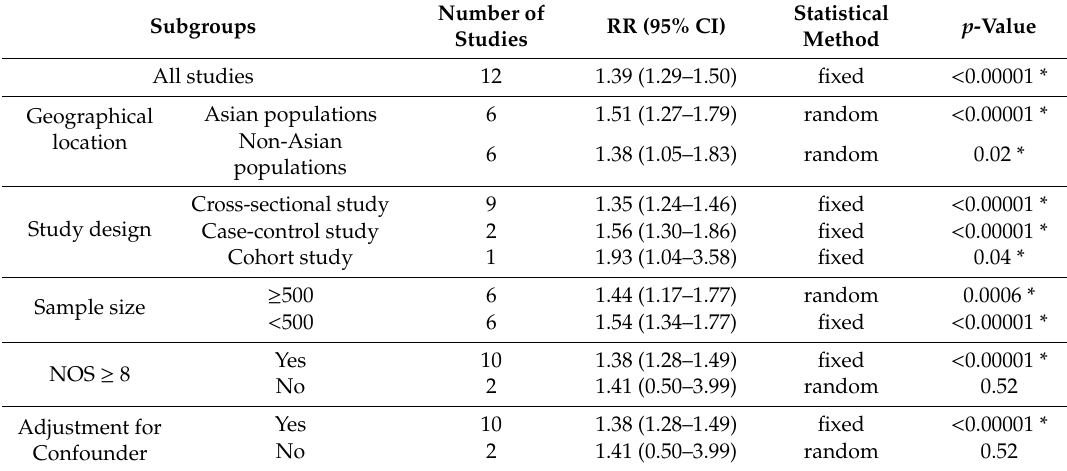
Table 2. Summary of subgroup